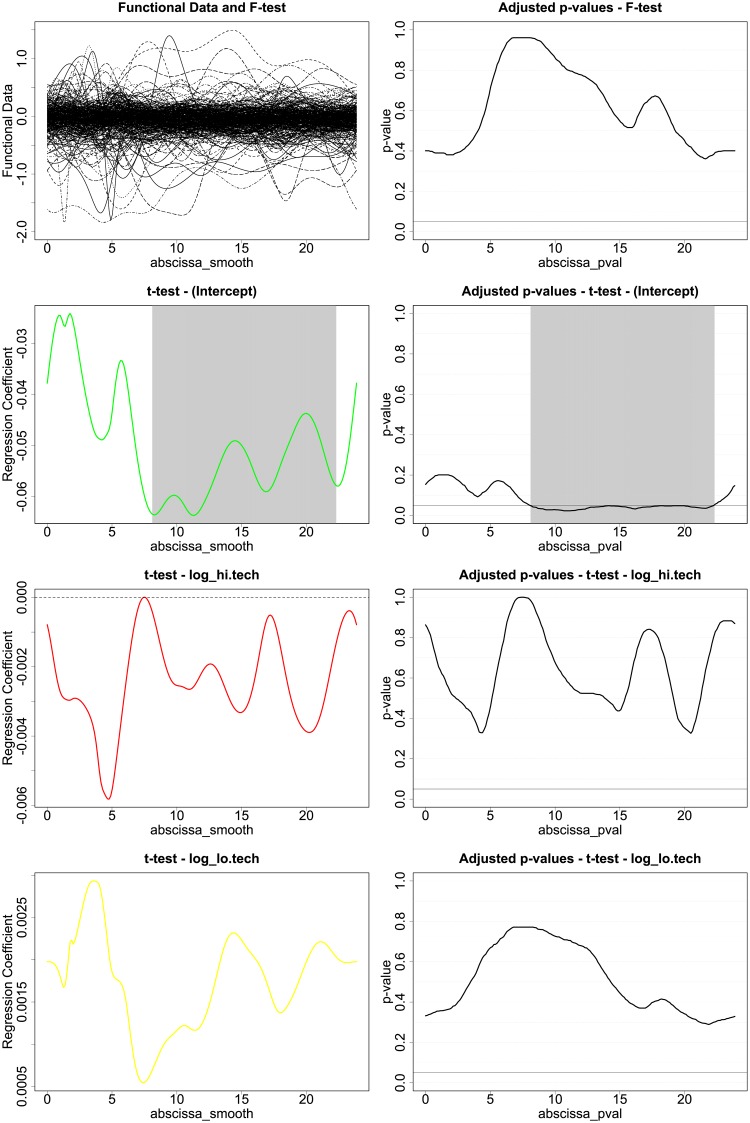
F-Test and t-Tests for regression model in Eq 8.